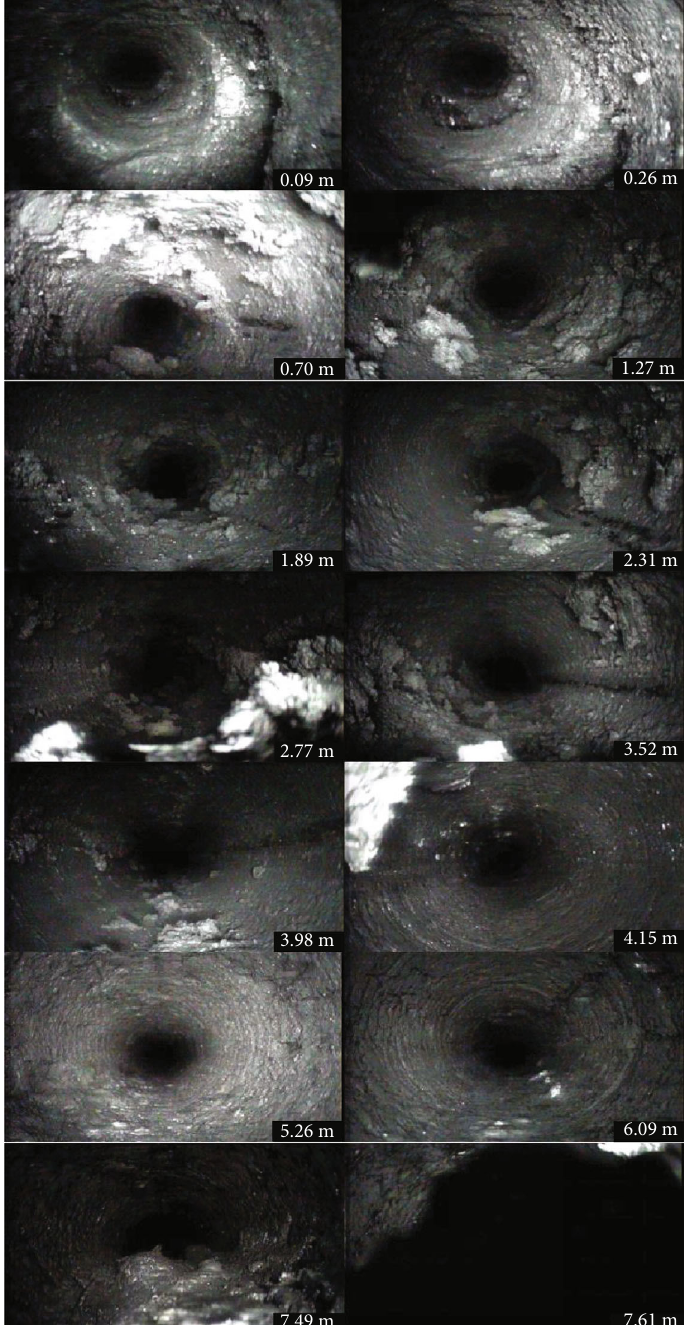
Figure 7: View of gas drainage boreholes in lower adjacent layer C 6a coal